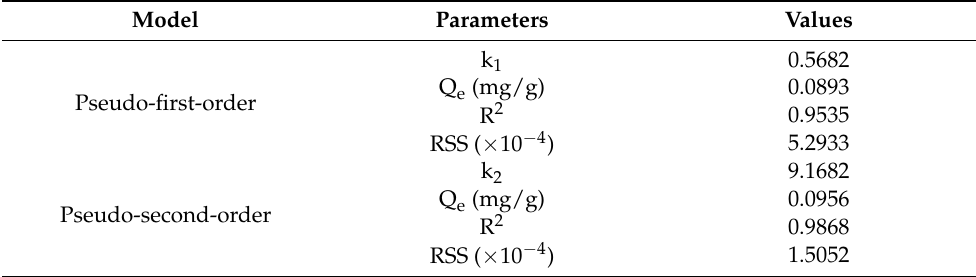
Figure 5. Pseudo-first-order, pseudo-second-order kinetics and removal rate for the adsorption of NH 4+ onto CB-GAC. (Experimental conditions: Initial pH: 7; CB-GAC dose: 10 g/100 mL; temperature: 25 ◦ C; initial concentration: 15 mg/L). Table 6. Parameters of kinetic models for the adsorption of NH 4+ onto CB-GAC.